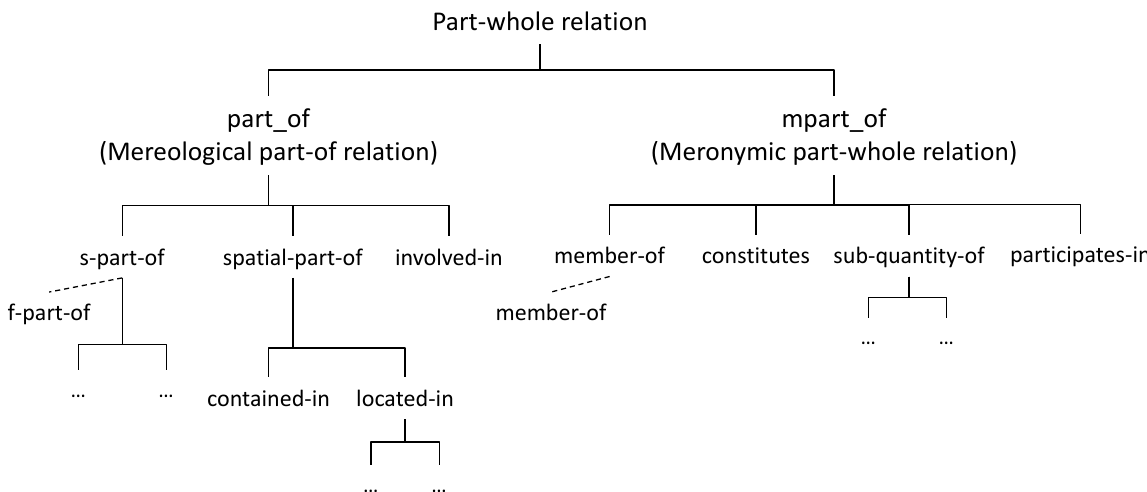
Figure 1. Keet et al .’s taxonomy of basic mereological and meronymic part-of relations. Part-whole